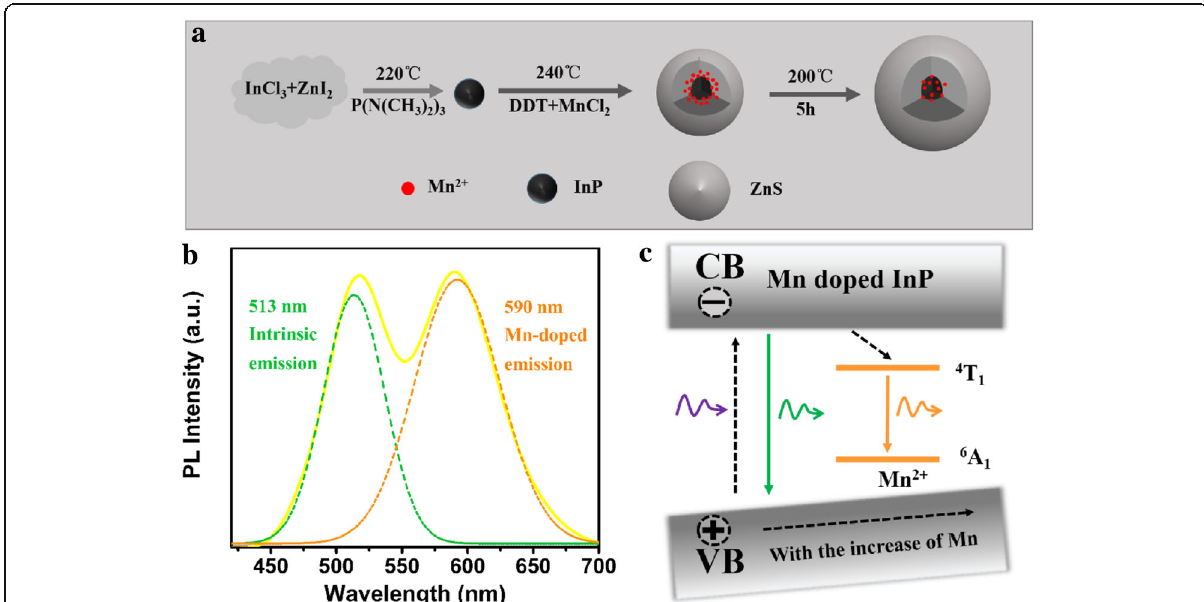
Fig. 6 a Schematic diagram for the synthetic process of Mn:InP/ZnS QDs. b Emission peak fitting result of Mn:InP/ZnS QDs (Mn/In=0.6) consisting of intrinsic emission and Mn-doped emission. c Schematic representation for the recombination mechanism of Mn:InP/ZnS